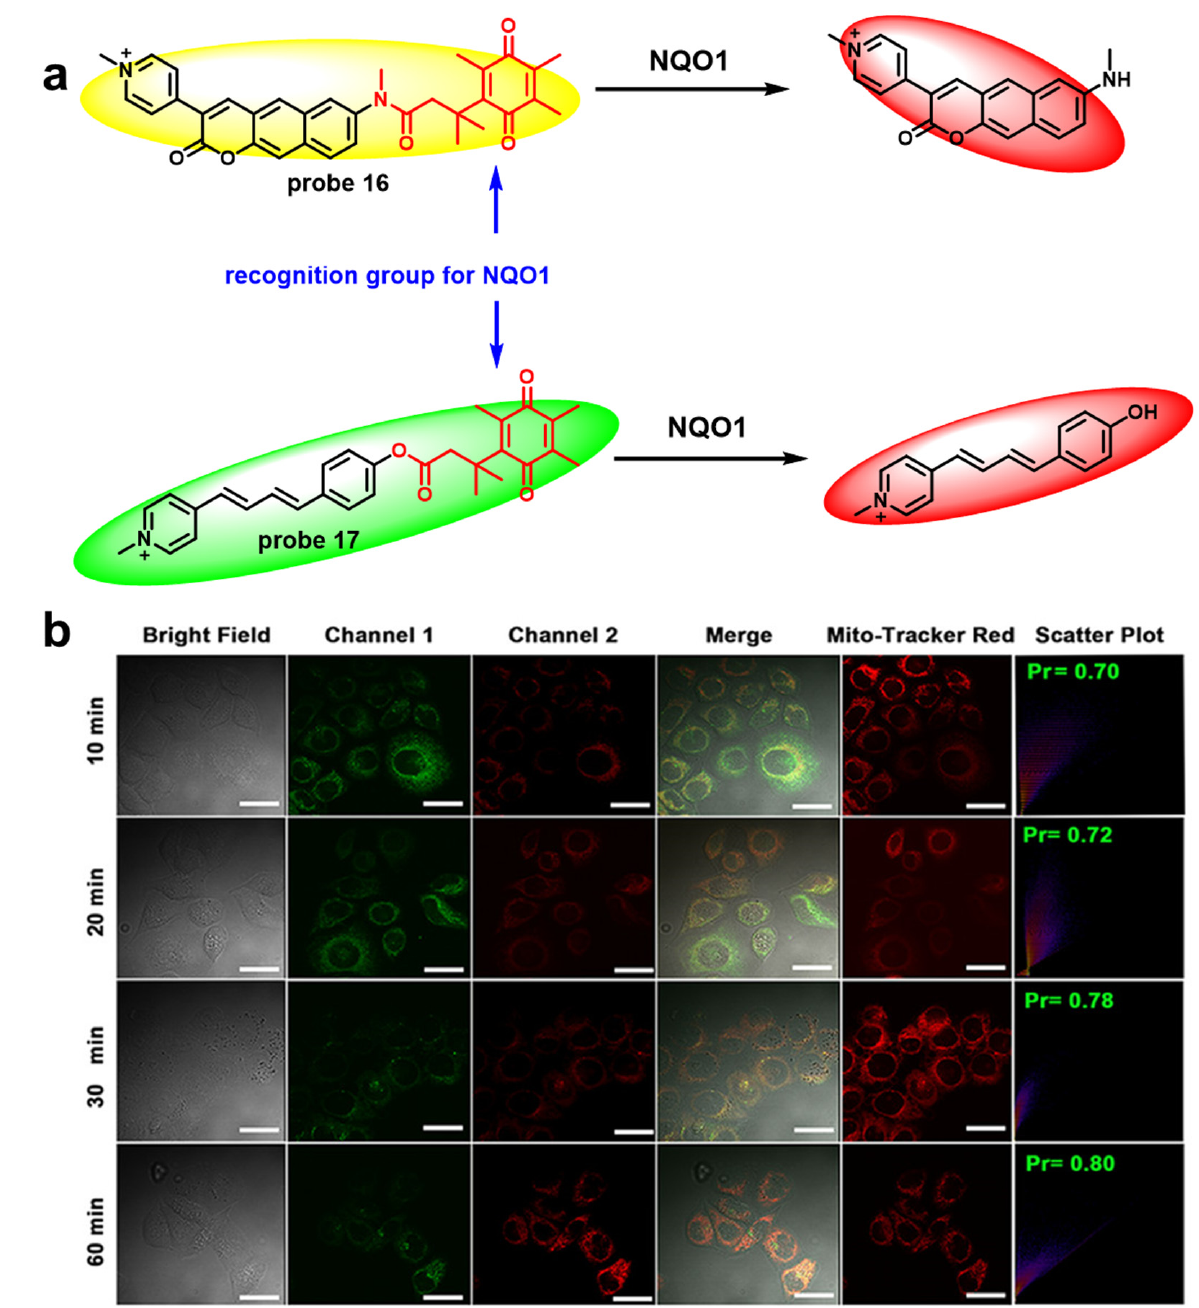
Figure 6. ( a ) Chemical structures of probes 16 and 17 ; ( b ) Confocal fluorescence images of HepG2 cells stained with 10 μ M probe 17 for 10, 20, 30, or 60 min followed by costaining with Mito-Tracker Red (500 nM) for another 0.5 h. Channel 1: λ ex = 790 nm and λ em = 505 ± 25 nm; channel 2: λ ex = 790 nm and λ em = 615 ± 25 nm; Mito-Tracker Red: λ ex = 559 nm and λ em = 590–650 nm. Merge: overlay of channel 1, channel 2, and bright field. Scatter plot: intensity correlation of fluorescence signals in the green channel (channel 1) and the Mito-Tracker Red channel Scale bar = 20 μ m. (Reprinted with permission from [51]. Copyright 2021 American Chemical Society.).